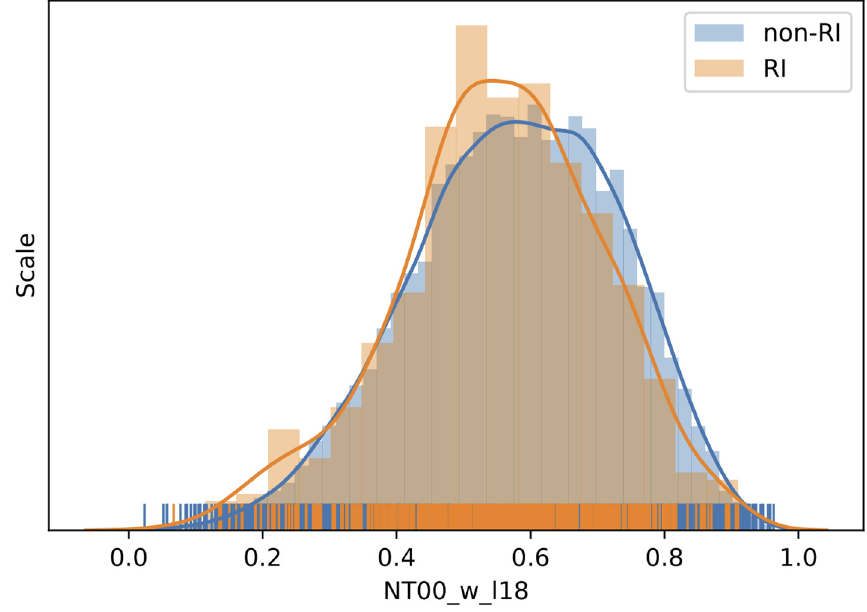
Figure 5. Same as Figure 2 but for variable NT00_w_l18 (pressure vertical velocity at 0 h at 400 hPa).